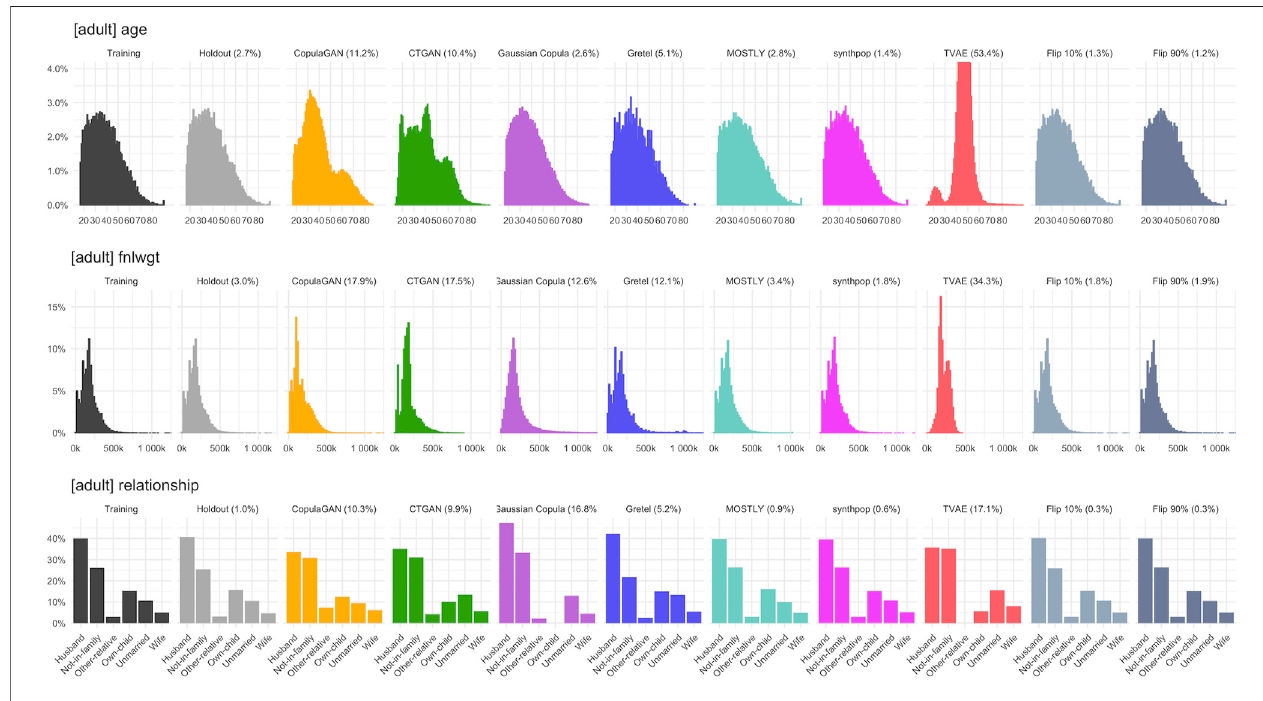
FIGURE 6 | Selected univariate marginal distributions for dataset “ adult ” across synthesized data and across perturbated data. Their total variation distance (TVD) with respect to the training set, displayed as percentages in brackets, contribute to the respective F 1 fi delity.